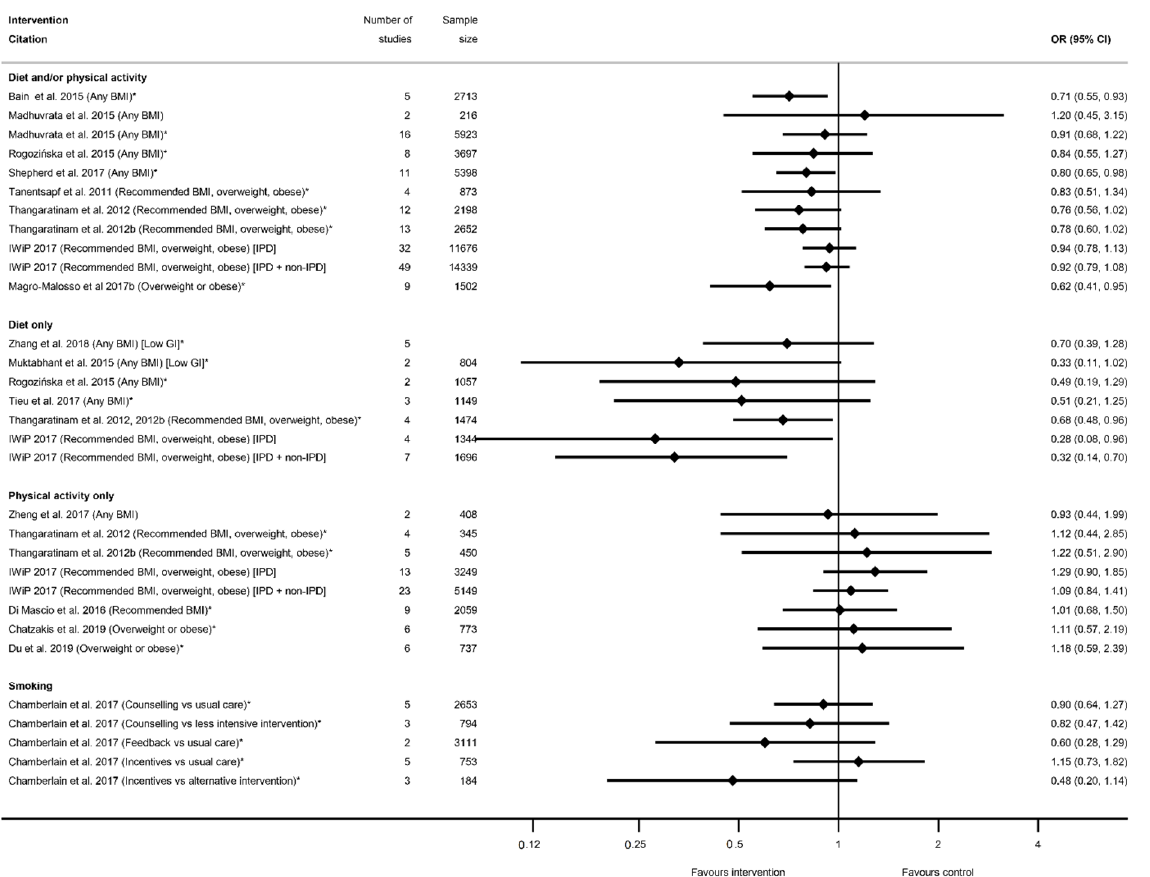
Figure 14. Forest plot of meta-analysis results for preterm delivery. * indicates the estimate is relative risk.